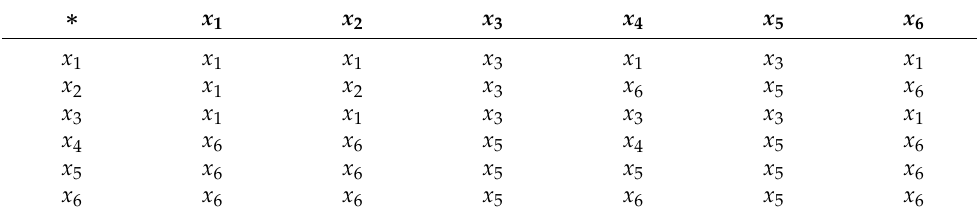
Table 8. A L1-transposition regular semigroup of Example